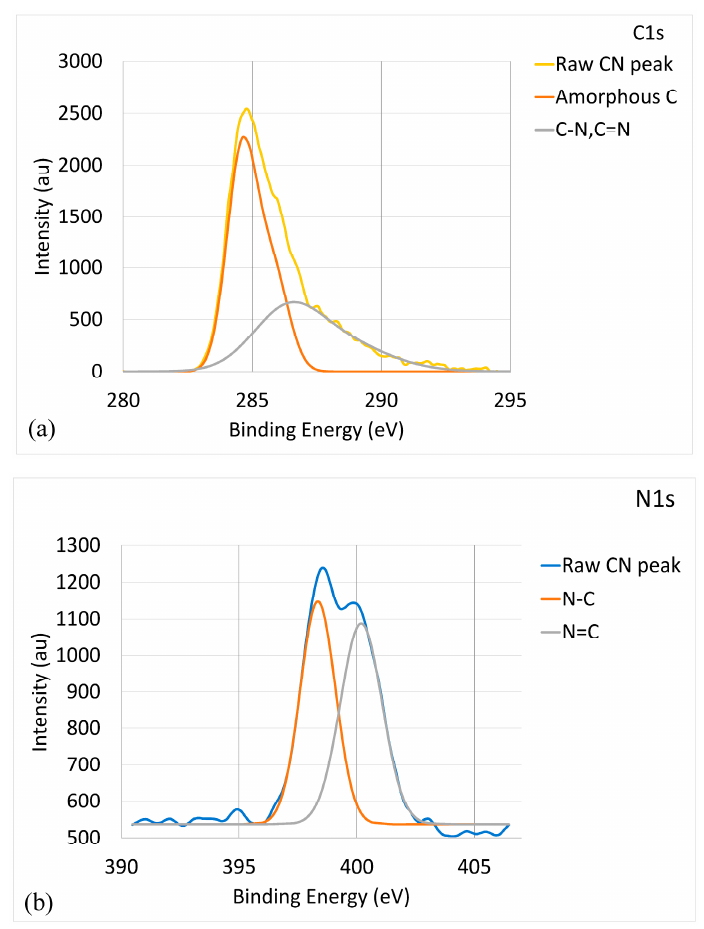
Figure 1. Bonding energy of CNx coating characterized by XPS: ( a ) C1s XPS raw and deconvoluted spectra; and ( b ) N1s XPS raw and deconvoluted spectra.